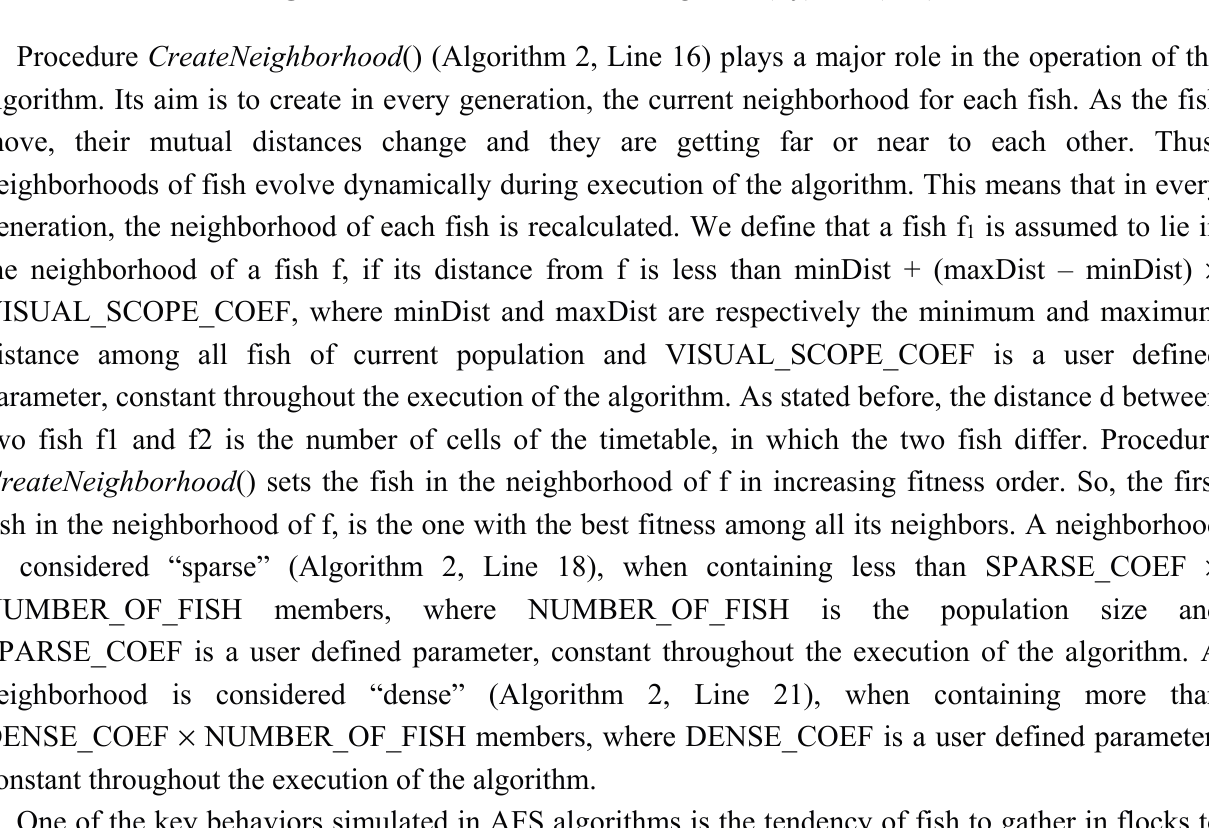
Figure 2. The fish f 1 after switching cells ( i , j ) and ( i , m